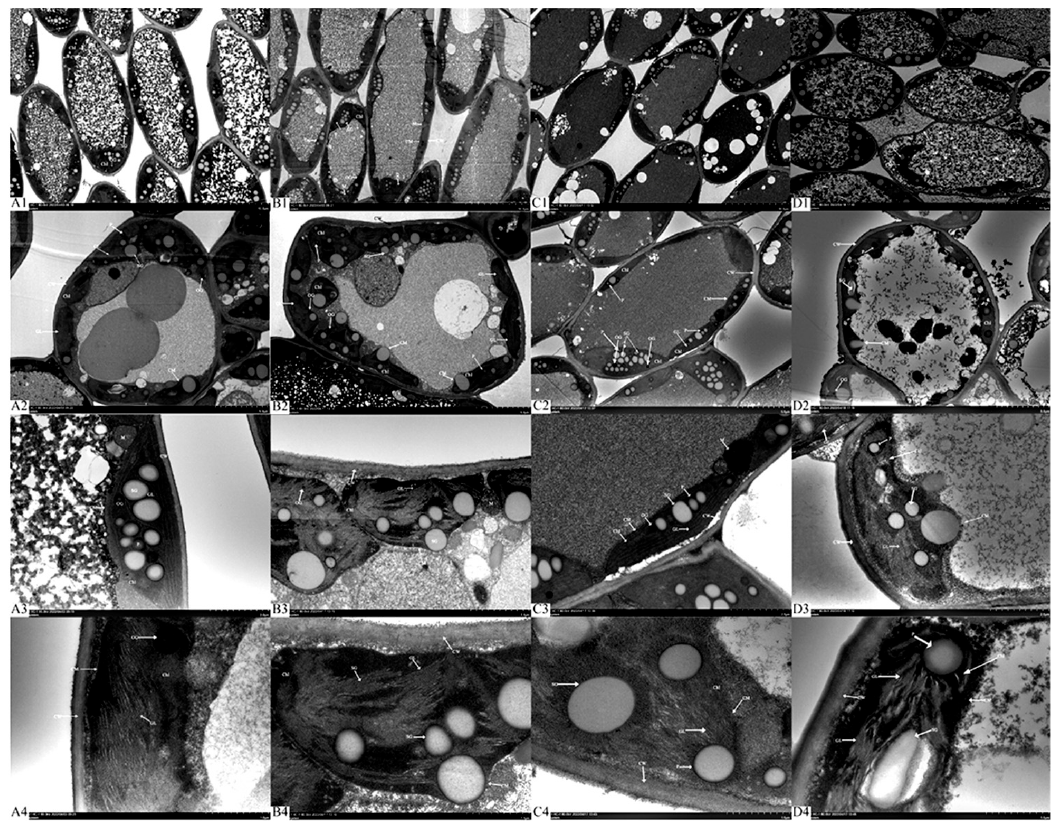
Figure 5. The effect of enhanced UV-B radiation on the chloroplast ultrastructure of leaves. Note: Chl, chloroplast; GL, grana lamellae; OG, osmiophilic globules; SG, starch grains; P, plastid granules; CW, cell wall; CM, chloroplast membrane. ( A1 – A4 ). 2.7 CK; ( B1 – B4 ). 2.7 enhanced UV-B radi- ation; ( C1 – C4 ). 2.17 CK; ( D1 – D4 ). 2.17 enhanced UV-B radiation. The same scheme applies to the